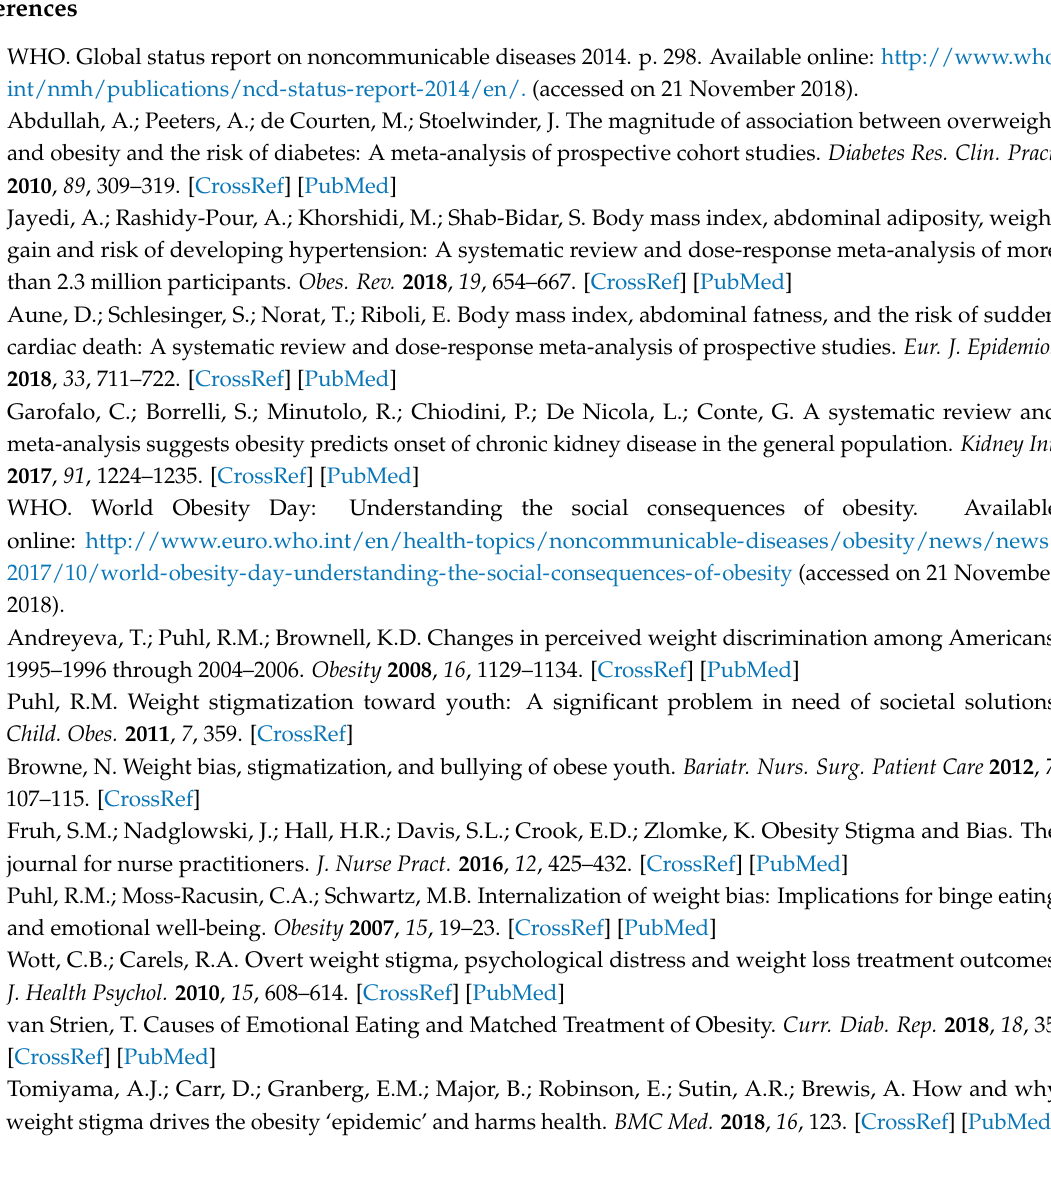
Table S2: The BodyMass-DRama questionnaire (Body Mass—Dietary Restrictions: Acceptance, Motivation, Attitudes)—component of body mass acceptance, Table S3: The BodyMass-DRama questionnaire (Body Mass—Dietary Restrictions: Acceptance, Motivation, Attitudes)—component of body mass beliefs, attitudes and emotions, Table S4: The BodyMass-DRama questionnaire (Body Mass—Dietary Restrictions: Acceptance, Motivation, Attitudes)—component of motivation towards body mass reduction, Table S5: The body mass acceptance of the studied group for the sub-groups stratified by WHtR, Table S6: The body mass beliefs, attitudes and emotions of the studied group for the sub-groups stratified by WHtR, Table S7: The motivation towards body mass reduction in the studied group for the sub-groups stratified by